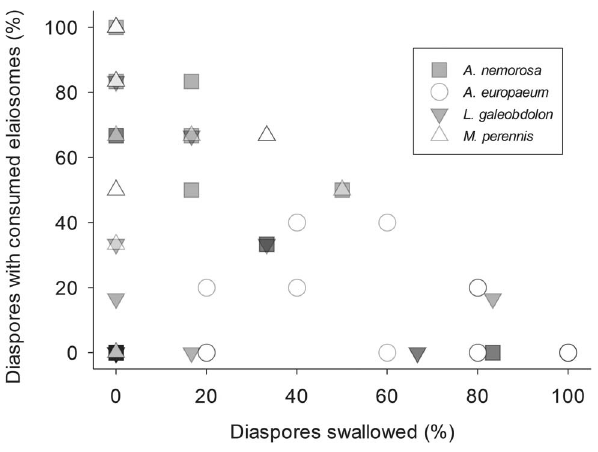
Figure 3. Different feeding behavior of diaspores by A.rufus individuals. Relationship of diaspores that were either swallowed or of which elaiosomes were consumed by A. rufus individuals. Each point represents a single feeding trial (N=89). The sum of both axes may not exceed 100% (=all diaspores offered were consumed) but may well be less if diaspores remained disregarded by slugs. There are great differences in the feeding behavior among individuals.